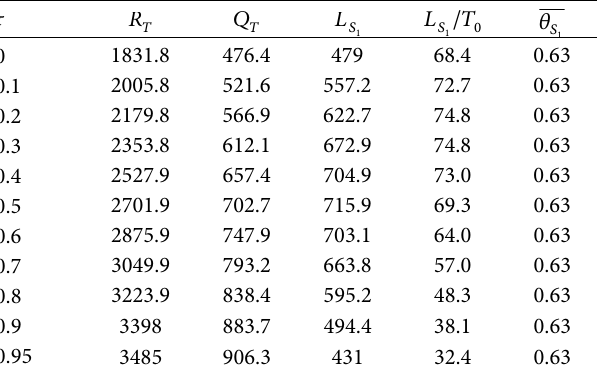
Table 3: Product sales and average freshness under basic fixed FKE.